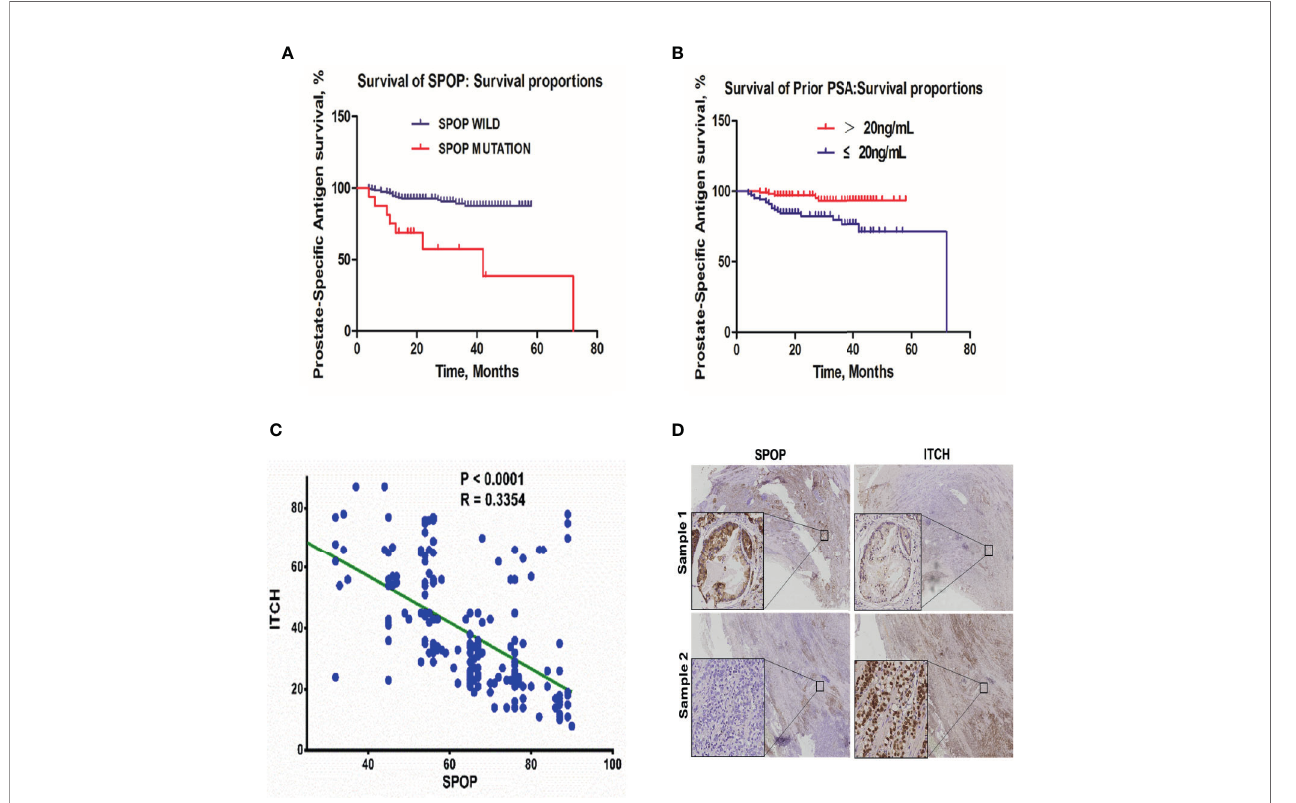
FIGURE 4 | The biochemical failure in the patient cohort. (A) Association of biochemical failure with SPOP mutations; (B) biochemical failure with prior PSA levels; (C) Linear regression correlation analysis of SPOP and ITCH expression levels. (D) Representative images of immuno-histochemical staining of SPOP and ITCH in prostate cancer tissue